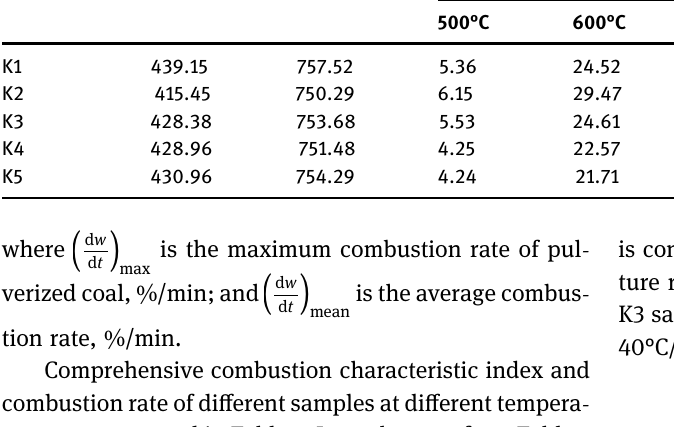
Table 2: Combustion parameters of mixed semi - coke samples Sample